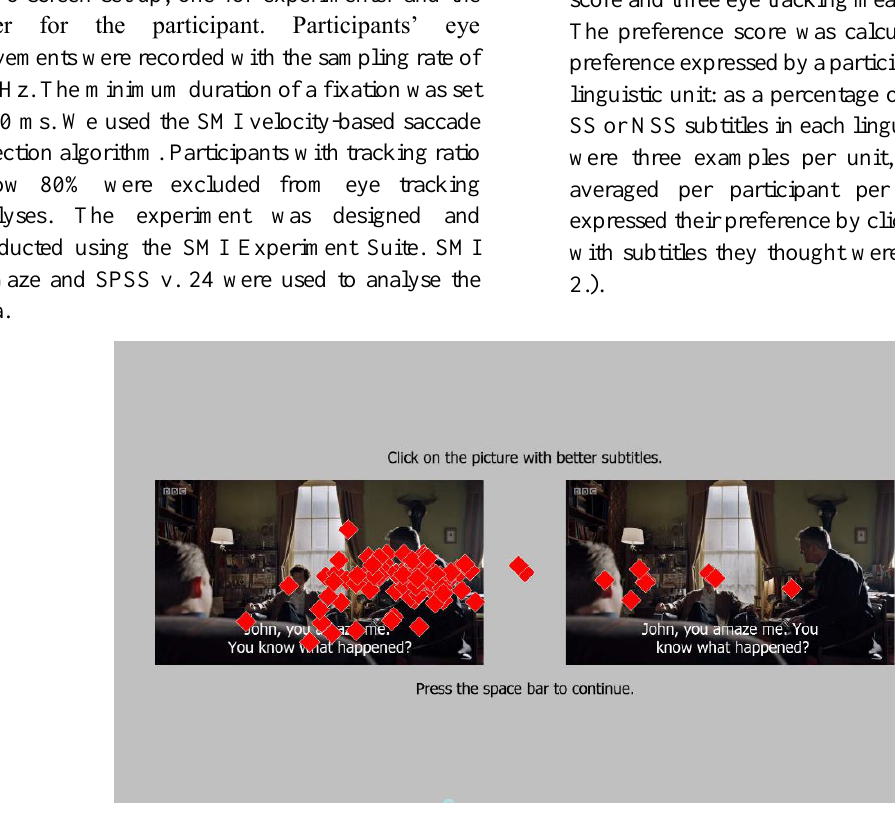
Figure 2. Visualisation of mouse clicks on syntactically segmented (left) and non-syntactically segmented (right) subtitles ( SentSent